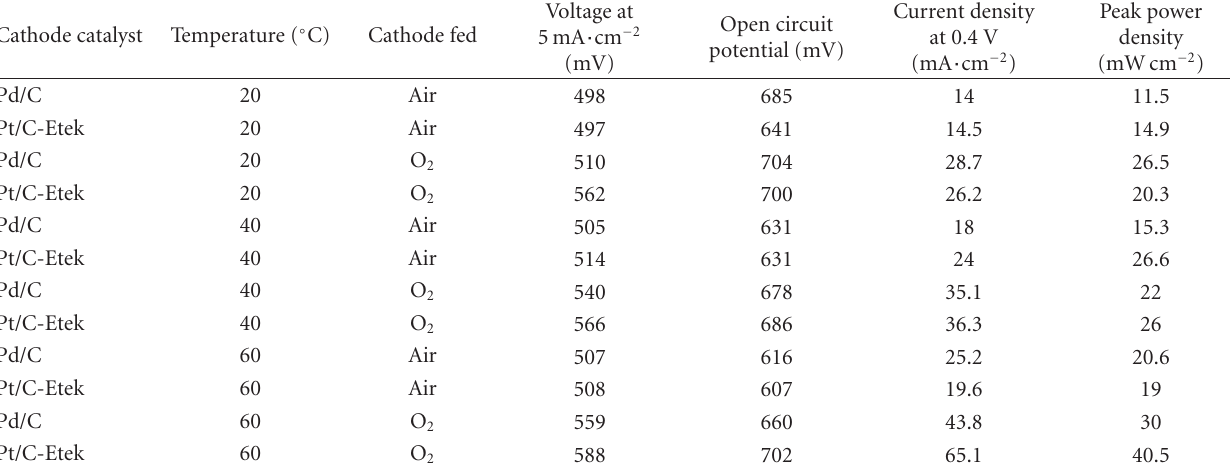
Table 4: Current densities at 0.4 V, cell voltage at 5mA · cm − 2 , open circuit potential and peak power densities for a direct methanol fuel cell with 5M methanol solution fed to the anode at 20, 40, and 60 ◦ C.